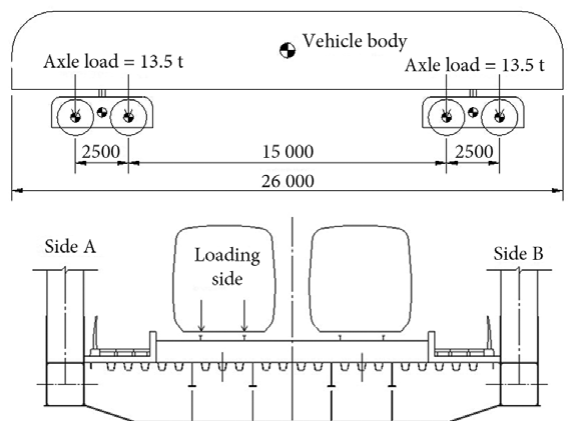
Fig. 2. Train axle pattern and loading locations for the analysis, in